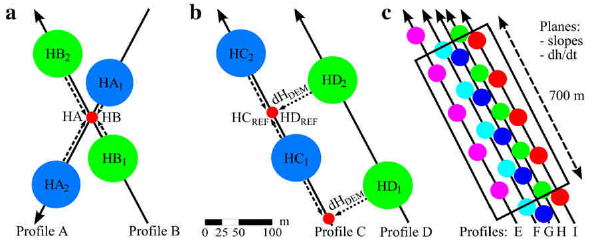
Figure 2. Three main methods adopted for calculating elevation changes (figure from Moholdt et al., 2010); a) crossover point analysis; b) cross-track DEM projection ; and c) space-temporal linear regression over regularly spaced